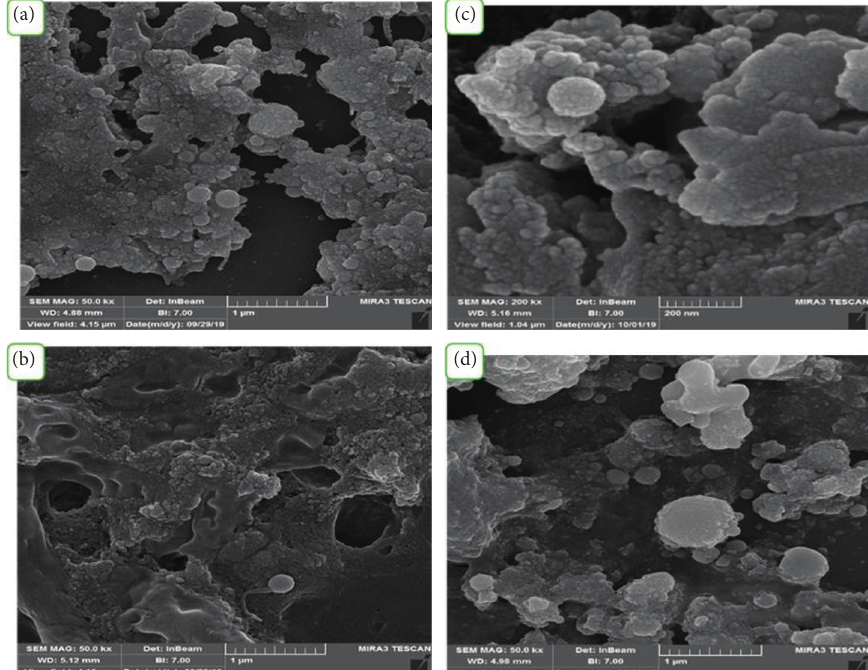
Figure 3: FE-SEM images of the prepared NPs: without applying a magnetic field and the LASER fluence: (a) 30mJ/cm 2 and (b) 60mJ/cm 2 ; with applying a magnetic field and the LASER fluence: (c) 30 mJ/cm 2 and (d) 60mJ/cm 2